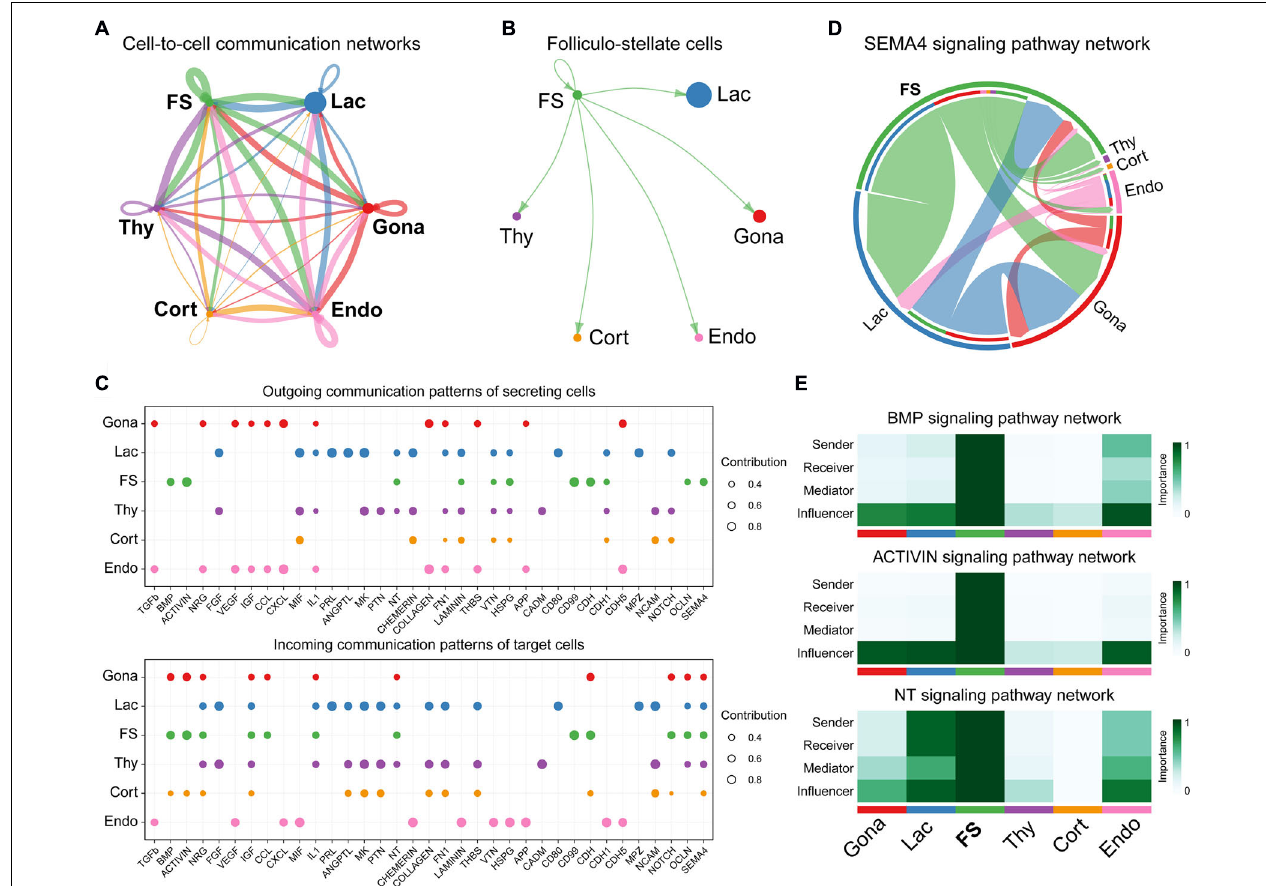
FIGURE 7 | Cell-to-cell communication exploration of six chicken pituitary cell types. (A) Network view of cell-to-cell communications within and across six pituitary cell types. The circle sizes are proportional to the number of cells in each cell group, and edges are in proportion to the counts of ligand-receptor interaction pairs. (B) The inferred FS-cells signaling networks. (C) Dot plots showing the alteration in outgoing (ligand) or incoming (receptor) signaling pathways in pituitary cell types. The dot size is proportional to the contribution score, which is calculated from pattern recognition analysis. Higher contribution score suggests that the signaling pathway is more enriched in the corresponding cell subset. (D) The inferred SEMA4 signaling network. The circle segments represent the six main intercellular communication cell types with different colors. The edge width is proportional to the communication score between interacting cell clusters. (E) Heatmap shows the relative importance of each cell group based on the computed four network centrality measures of BMP, ACTIVIN, and NT signaling network,